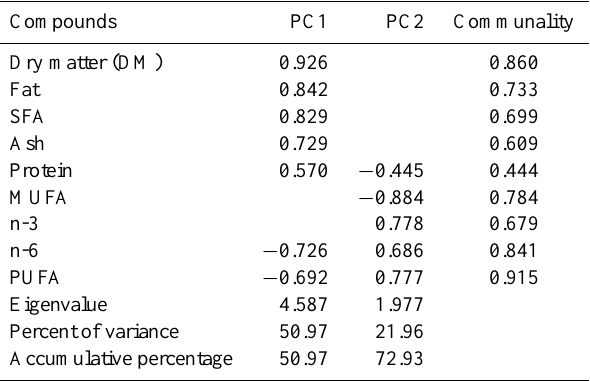
Table 6. Factor loadings ∗ for the rotated factor of the first two prin- cipal components